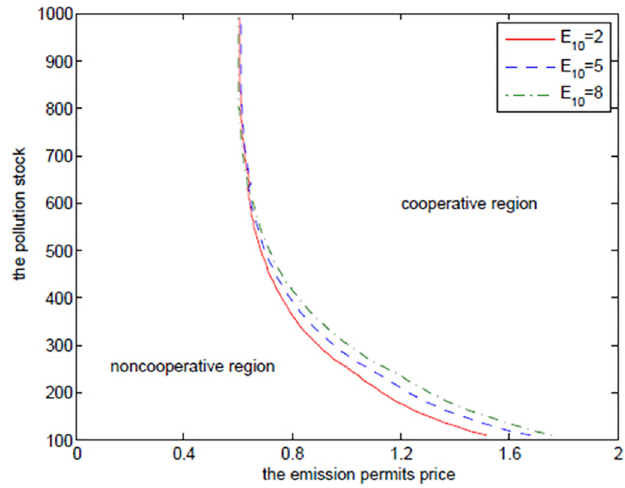
Fig 16. The effects of E 10 on the optimal decision